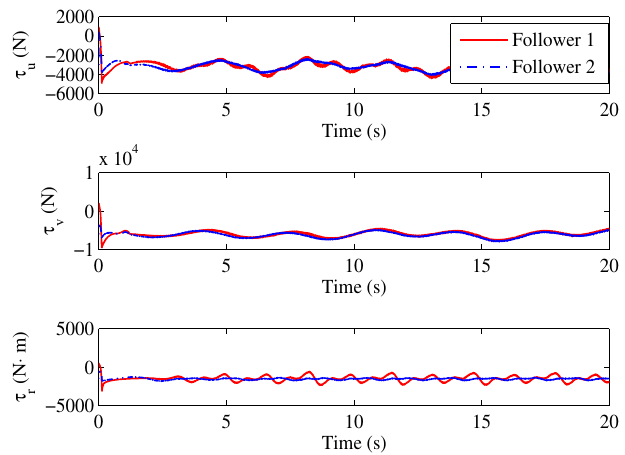
Figure 18. Control inputs of the